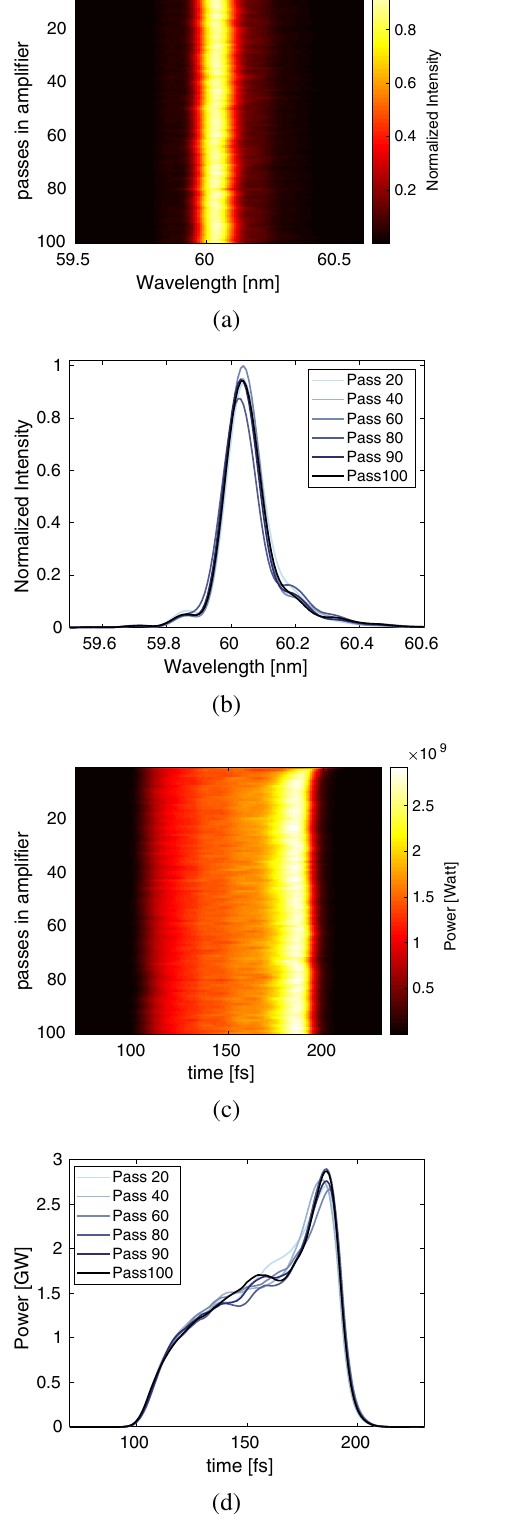
FIG. 5. 12th harmonic of a 50 nm seed light pulse. (a) Output spectrum per pass at amplifier. (b) Output spectrum for selected passes. (c) Power per pass in amplifier along the intrabeam coordinate s . (d) Output power profile for selected passes.